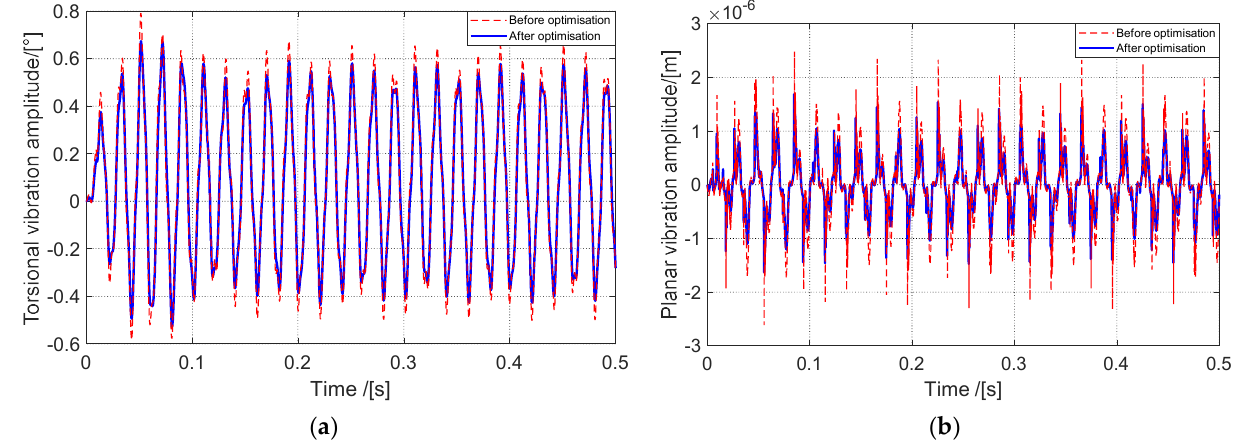
Figure 13. Comparing the results of before and after optimization: ( a ) results of torsional vibration; ( b ) results of planar vibration.